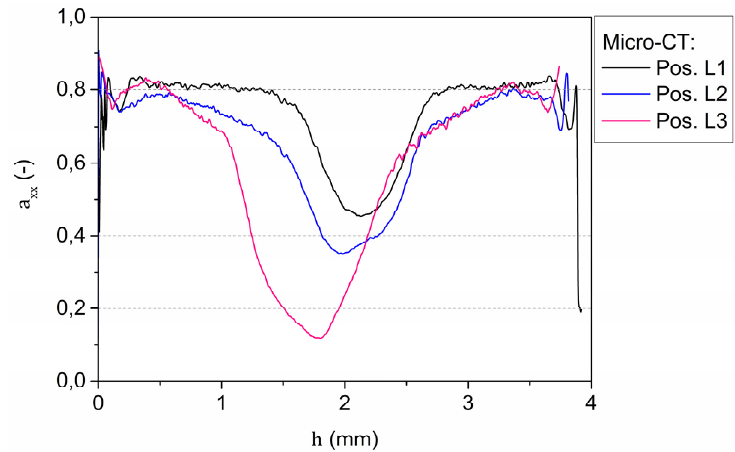
Figure 3. Difference of tensor component a xx as representation of glass fiber orientation in flow direction, analyzed by 3D X-ray MicroCT for the positions L1, L2 and L3 in the plate (see Figure 1).